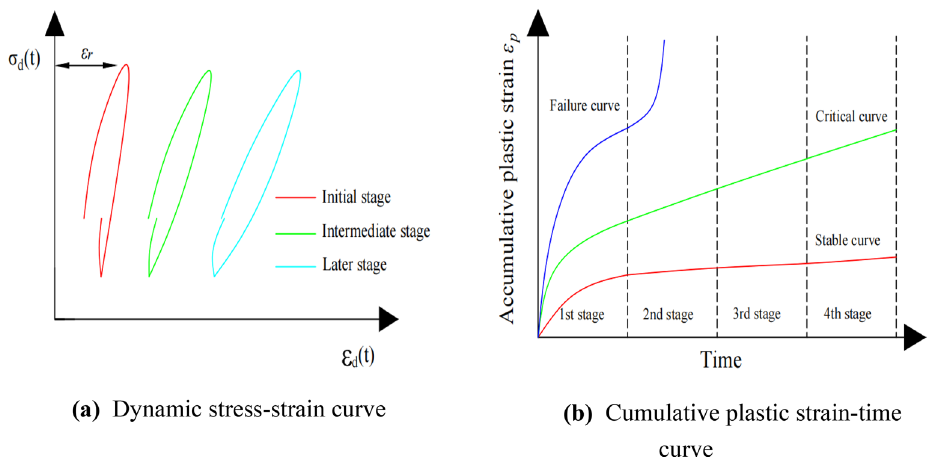
Figure 3. ( a ) Dynamic stress–strain curve. ( b ) Cumulative plastic strain–time